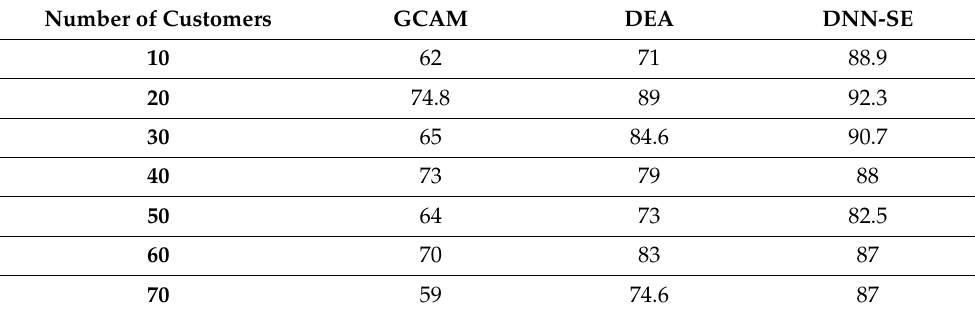
Table 2. Total power consumption.